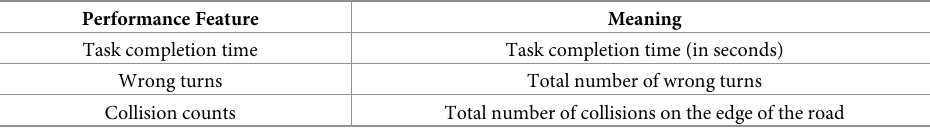
Table 1. Performance features and their